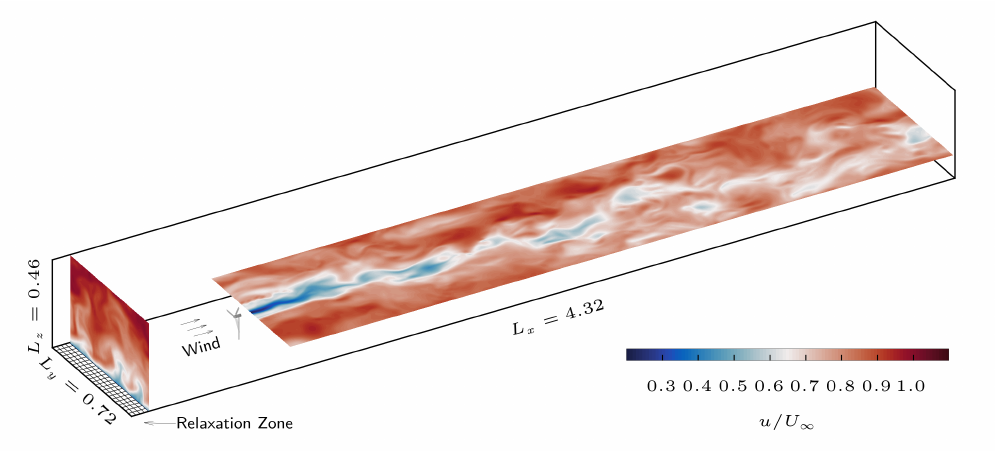
Figure 3. Illustration of the computational domain. The wind blows in the x direction. A turbine model is deployed at a distance of 0.75 m from the inlet. A turbulent inflow database is imported in the velocity relaxation zone